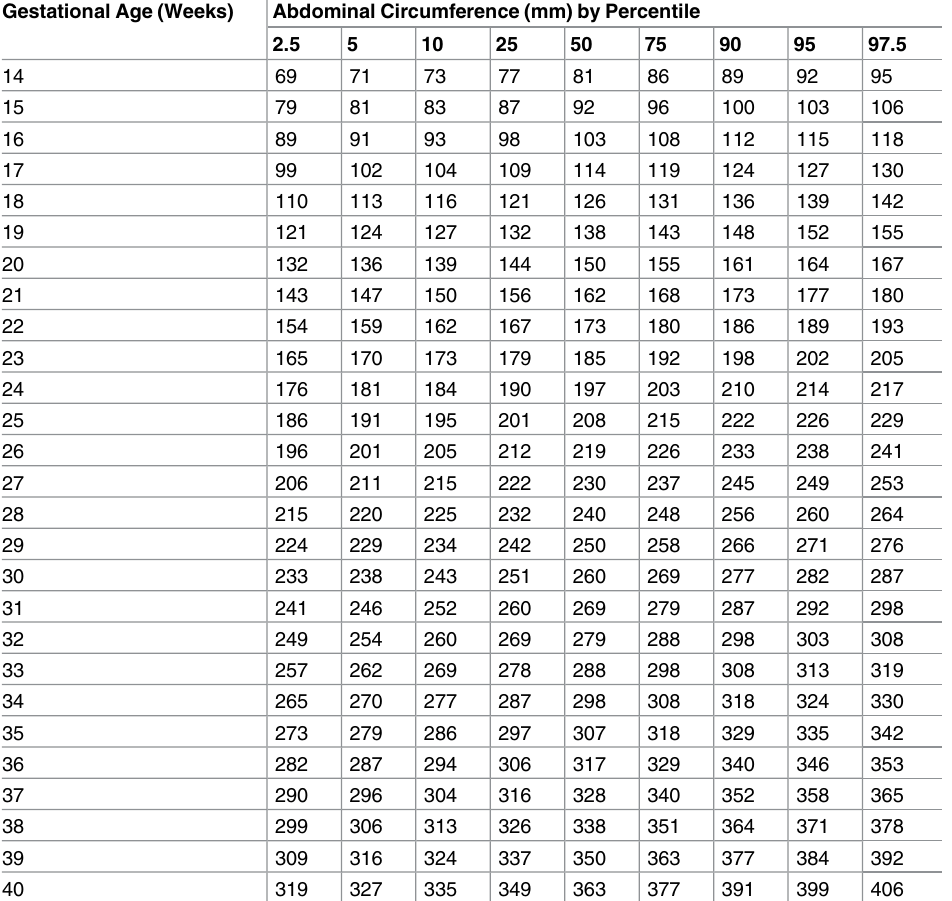
Table 8. Growth chart for fetal abdominal